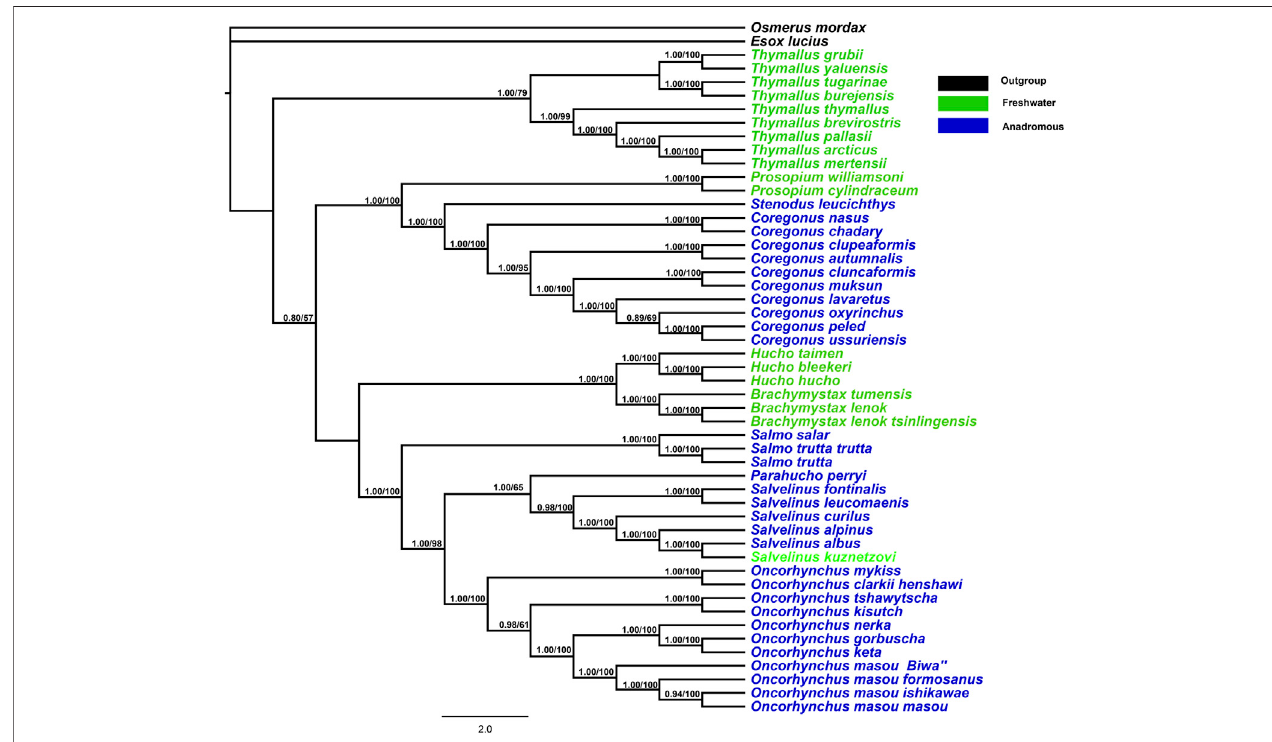
FIGURE1| Phylogenetictreeconstructedforcombining13mitochondrialprotein-codinggeneorthologsusingRAxMLandBayesianinferencemethods.MrBayes with GTR+I+G model was used. The Bayesian posterior probabilities and bootstrap support values are indicated at the nodes.